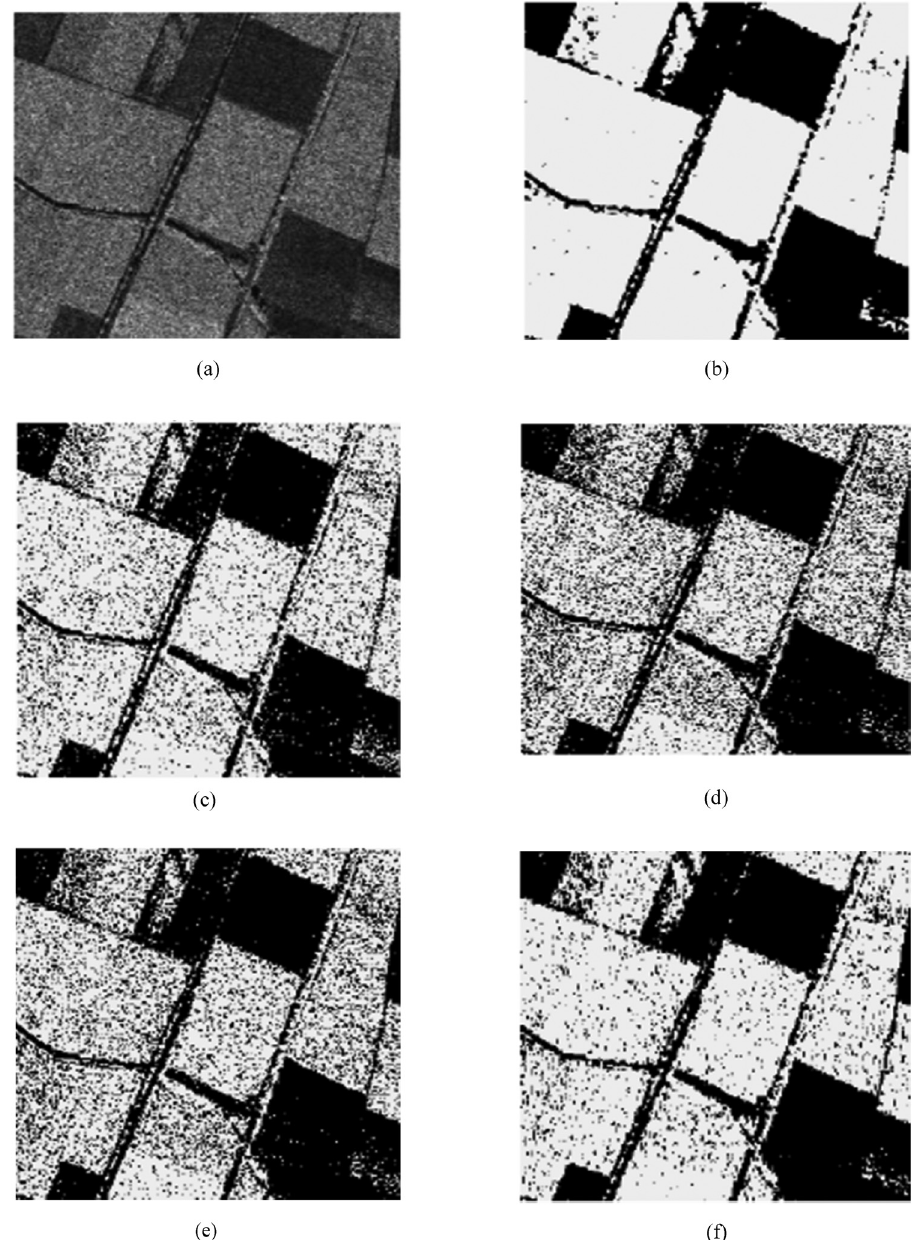
Figure 4: Segmentation results of farmland SAR image. ( a ) Original image, ( b ) OEA - ISODATA algorithm, ( c ) PSO - ISODATA algorithm, ( d ) FCM algorithm, ( e ) K - means algorithm, and ( f ) WIPFCM